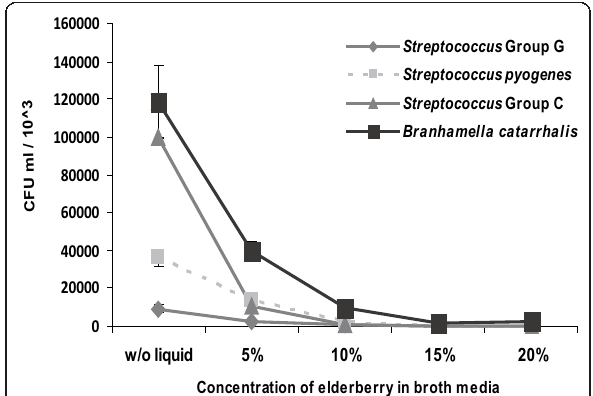
Figure 1 Effect of the elderberry extract on bacterial growth . Visualization of Gram-positive and Gram-negative bacterial strains exposed to different concentrations of Rubini elderberry extract during growth in liquid culture. Every biological experiment was independently repeated at least three times with two replicates per trial. Standard deviation is indicated. The p < 0.05 was observed for all bacterial species tested.